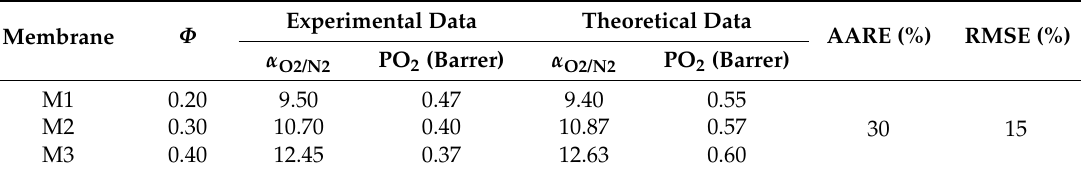
Table 1. Experimental [39] and theoretical (membrane optimization tool) MOT-predicted data for the